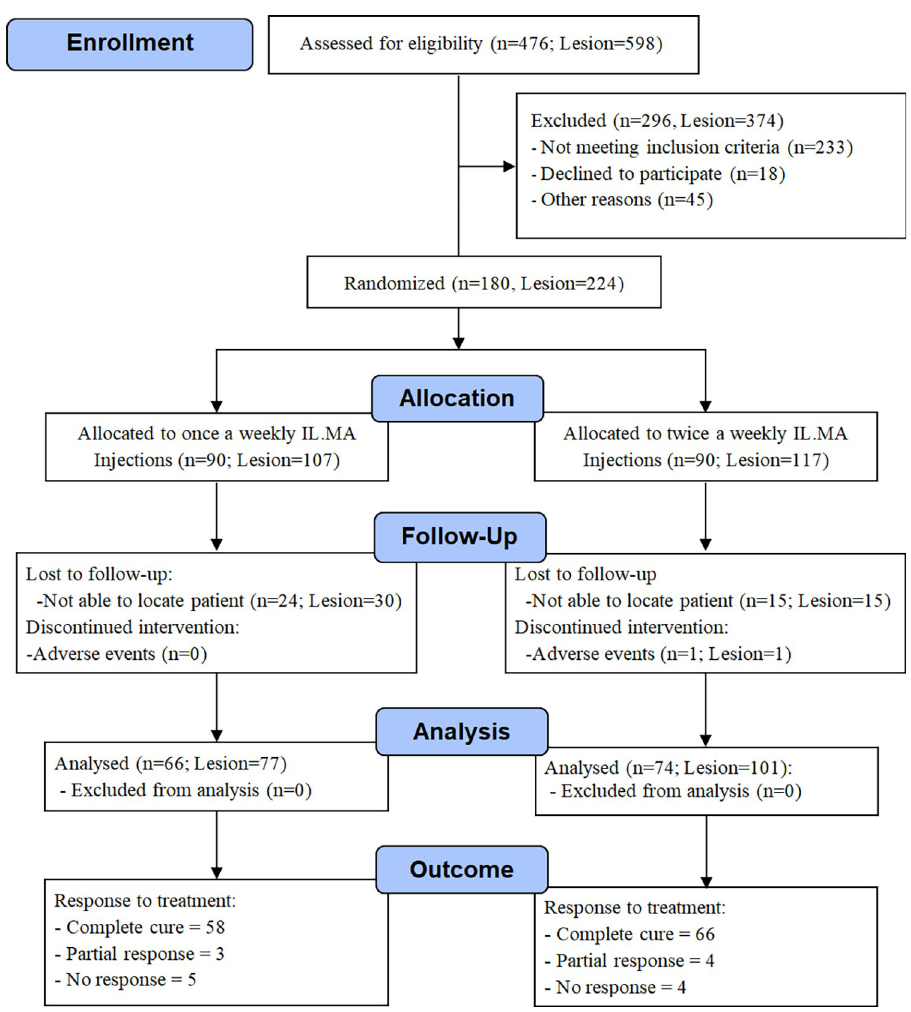
Fig 1. Flow diagram of patient enrollment treatment and follow